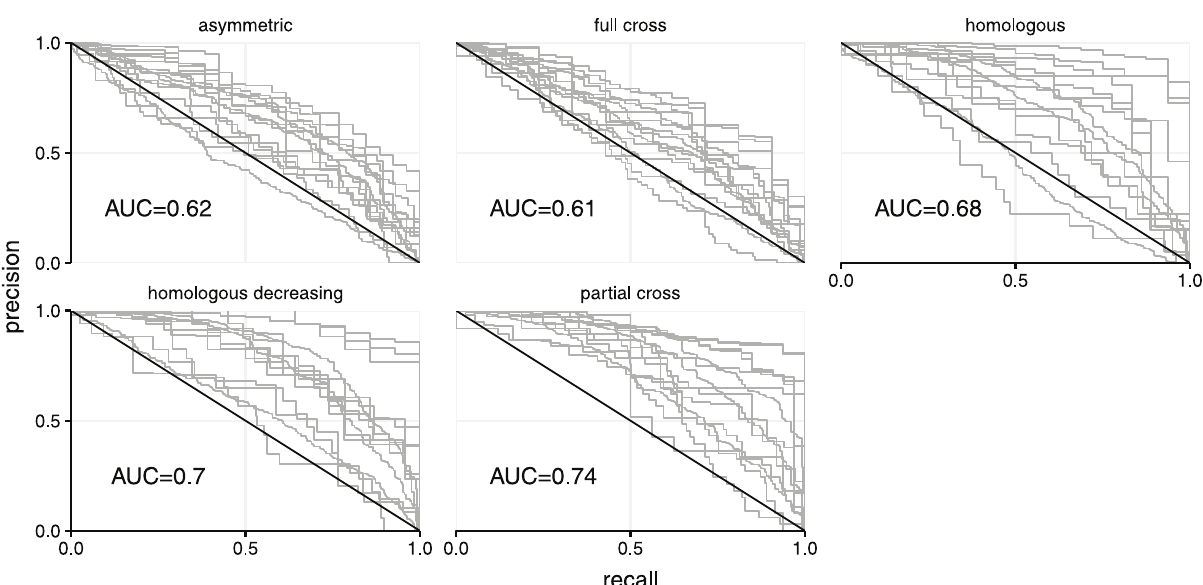
Fig 5. Precision-recall curve for multinomial models under five distinct immunity assumptions. Precision (resp. recall) is defined as the percentage of true positives among all positives (resp. true positives plus false negatives). The area under the curve (AUC) indicates increased (compared to random AUC of 0.5) power to classify a host’s node degree using infection barcode connectivity information.